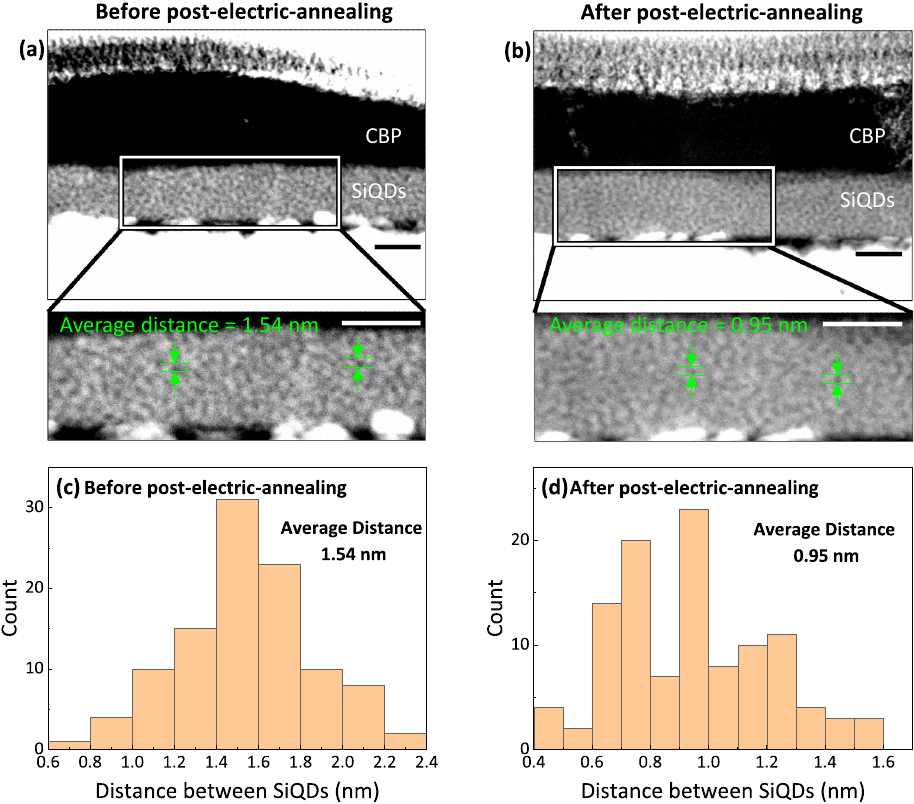
Figure 4. Cross-sectional HAADF-STEM images of Si-QLEDs and histogram of distance between SiQDs in the active layer ( a,c ) before and ( b , d ) after post-electric-annealing. For post-electric-annealing, the device was applied voltage for 22 h at 5 V. Each scale bar is 20 nm.